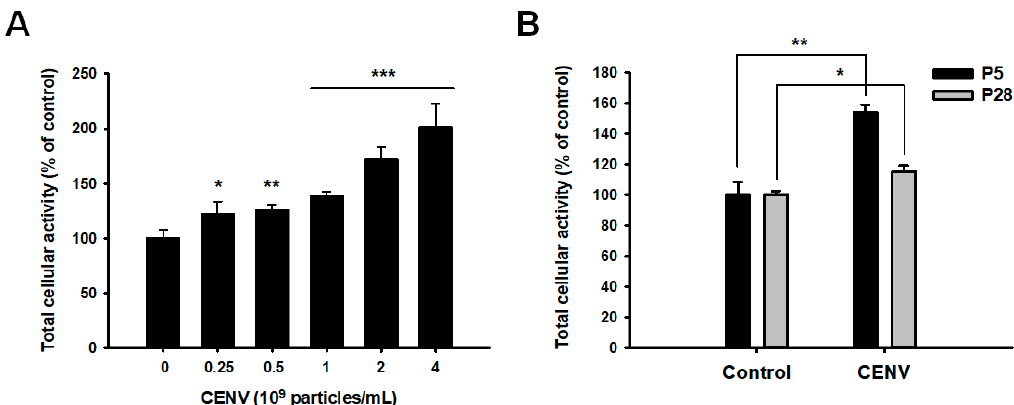
Figure 4. E ff ect of iPSC-CENV on the proliferation of human dermal fibroblasts (HDFs). ( A ) After serum starvation, cells were treated with iPSC-CENVs for 48 h in serum-free condition. The population of active HDFs was determined by water-soluble tetrazolium salt-8 (WST-8) assay. The value of iPSC-CENV-untreated cells was regarded as 100%, and the populations of other treated groups were represented as relative values. ( B ) Serum-starved young (under passage number 5, P5) and senescent (over passage number 28, P28) HDFs were treated with particle number 2 × 10 9 / mL of iPSC-CENVs for 48 h in serum-free condition, respectively, then the active cell populations were determined by WST-8 assay. Statistical significance (* p < 0.05, ** p < 0.01, and *** p < 0.005 compared to the iPSC-CENV-untreated group) was determined using Student’s t -test. Error bars indicate the standard deviation of triplicate experiments.